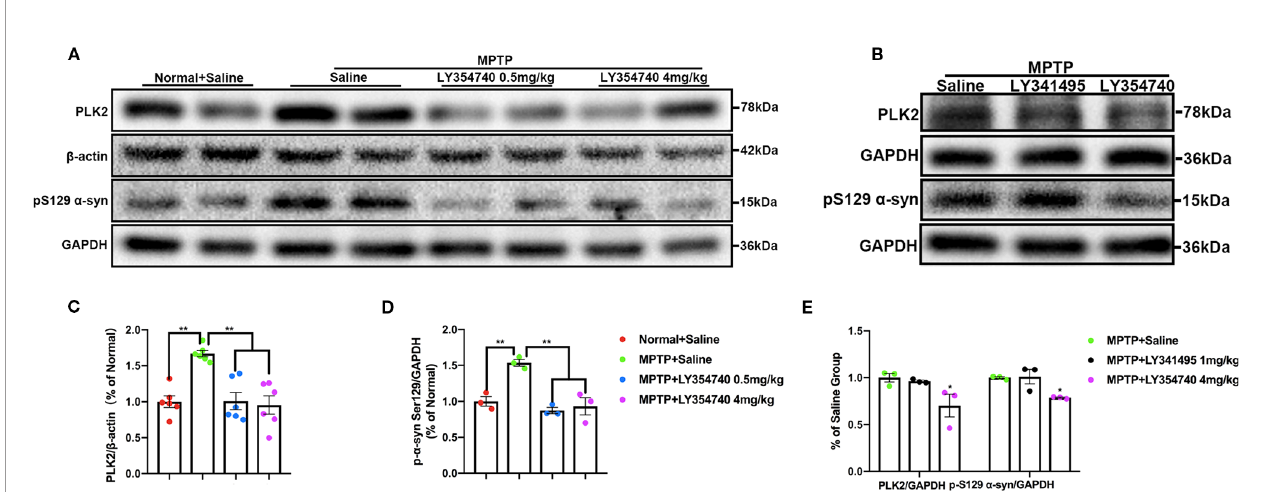
FIGURE 8 | The effect of ligands of mGlu 2/3 receptors on expression of polo-like kinase 2 (PLK2) and phosphorylated a -synuclein at Ser129 in substantia nigra (SN) of acute 1-methyl-4-phenyl-1,2,3,6-tetrahydropyridine (MPTP)-induced Parkinson ’ s Disease (PD) mice model. Immunoblots (A) and relevant histograms (C, D) represent expression of PLK2 and phosphorylated a -synuclein at Ser129 in SN of each group. Band intensity of particular target proteins were normalized to b -actin or glyceraldehyde 3-phosphate dehydrogenase (GAPDH) level. **p < 0.01. N = 6 in (C) ; N = 3 in (D) . Data were expressed as % of the normal + saline group and shown as the mean ± SEM. (B, E) Western blots represent expression of PLK2 and pS129 a -synuclein in SN of acute MPTP-treated mice with different drug intervention. *p < 0.05 compared with the other two groups. N = 3. Data were expressed as % of the MPTP + saline group and shown as the mean ±